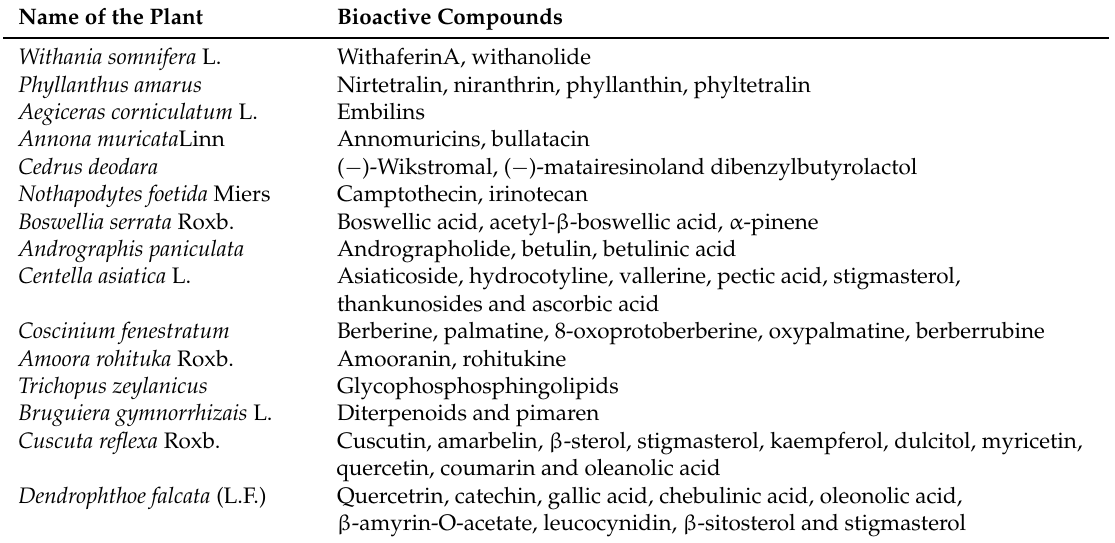
Table 1. Bioactive compounds from selected South Asian medicinal